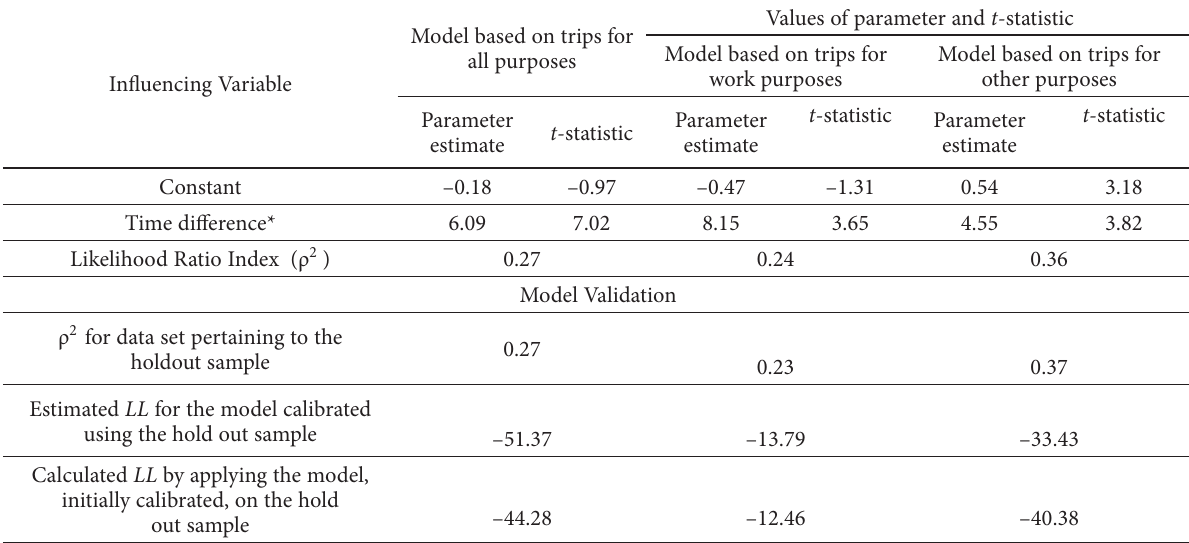
Table 6. Th e results of the calibration and validation of models with travel-time diff erence as the only causal variable